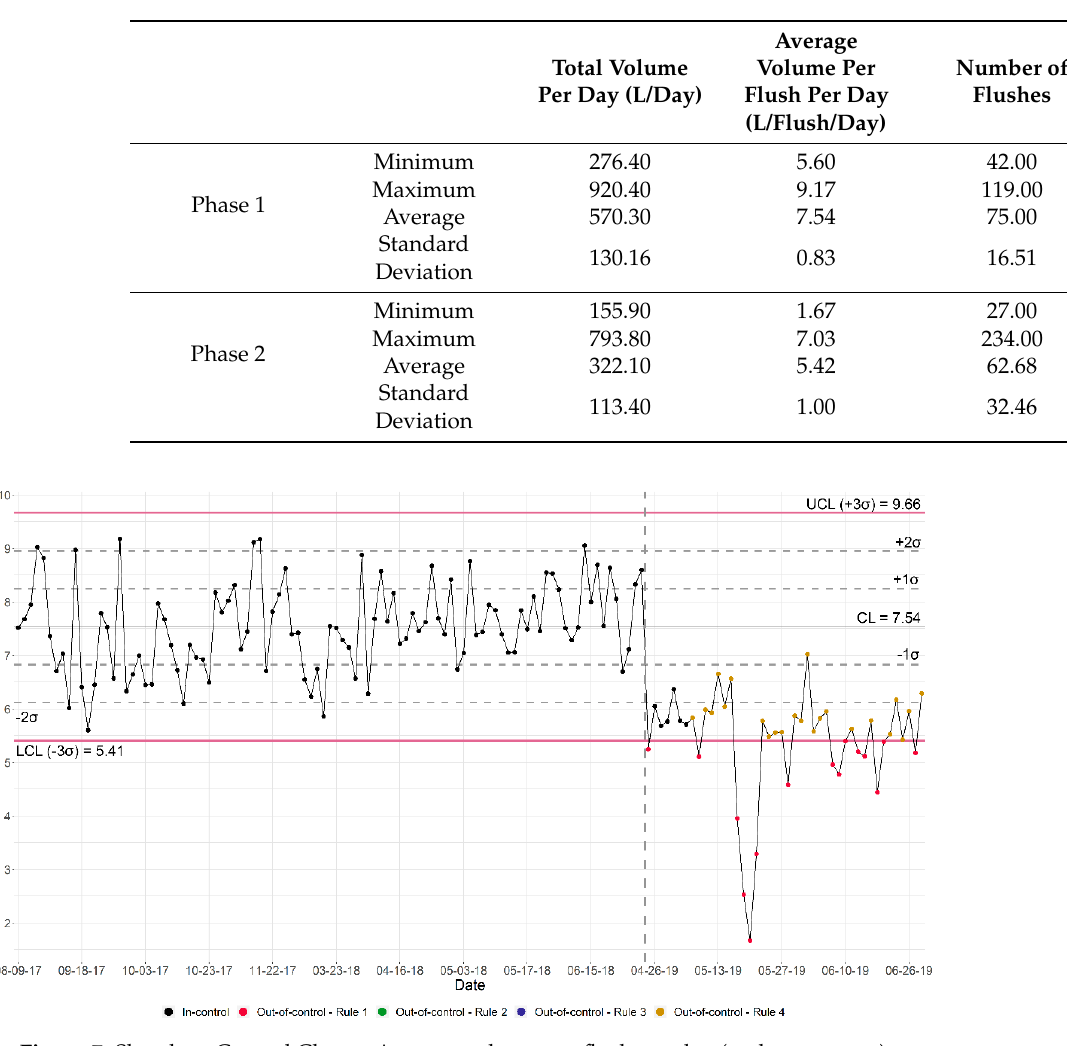
Table 3. Male Restrooms—Phases 1 and 2 summaries.